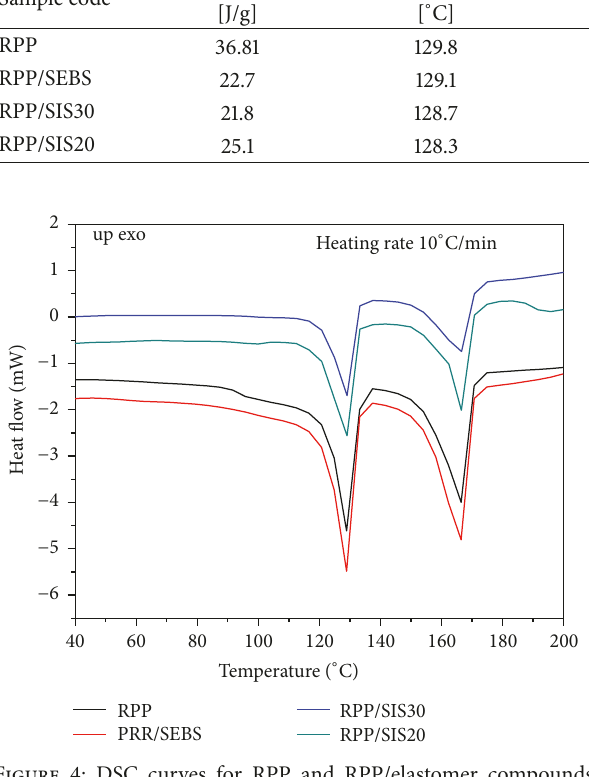
Figure 4: DSC curves for RPP and RPP/elastomer compounds containing 10% elastomers.